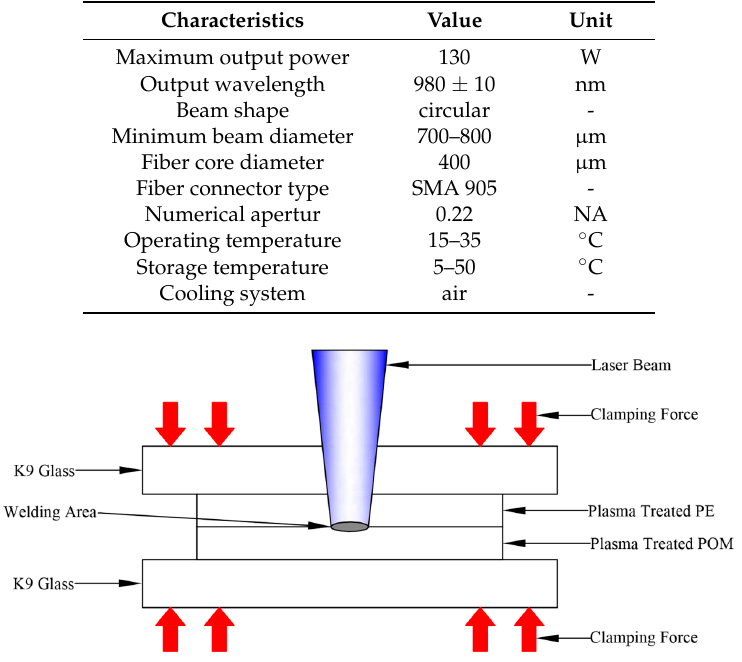
Table 1. Laser source characteristics.